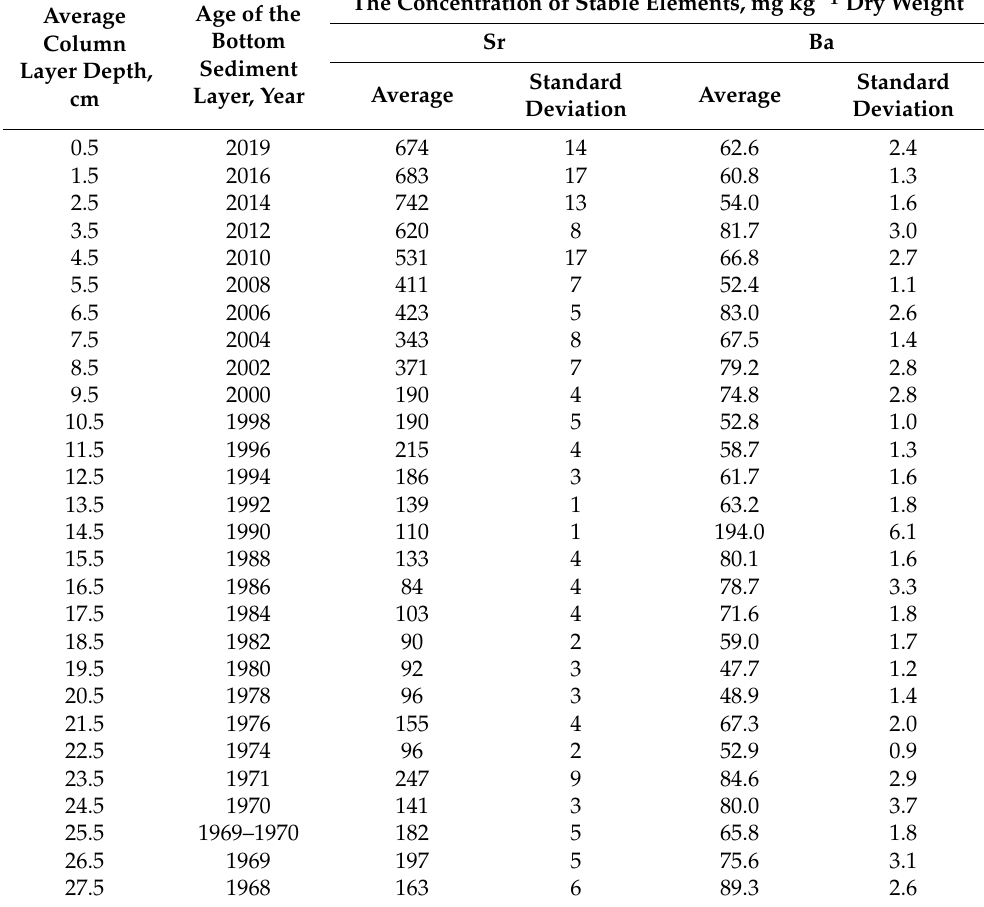
Table 2. Sr (stable) and Ba concentrations in the core of bottom sediments taken in Lake Aktashskoye for geochronological studies (6 November